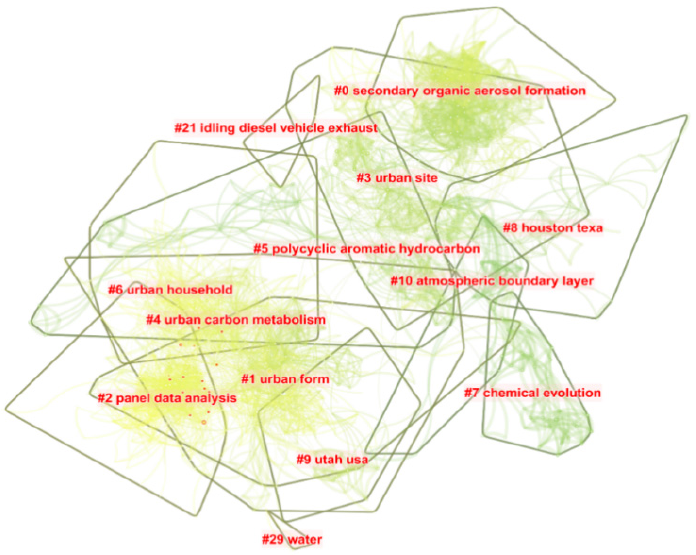
Figure 7. The document co-citation network. The "#" and number indicate the serial number of the clusters with the largest to the smallest number. Table 2. Summary of the largest 10 clusters.